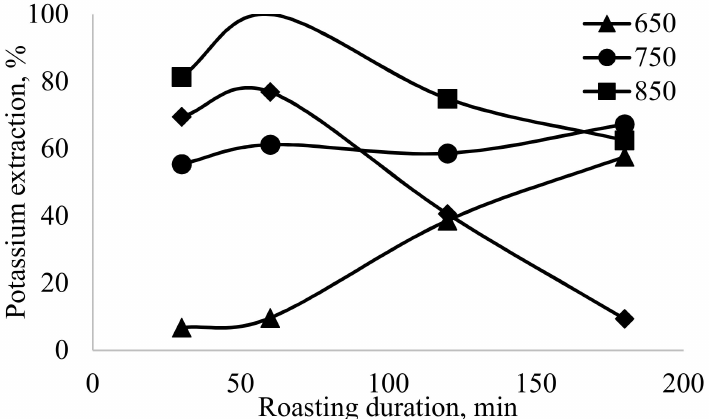
Figure 6. Potassium extraction recoveries of the roasted sample at different temperature values and